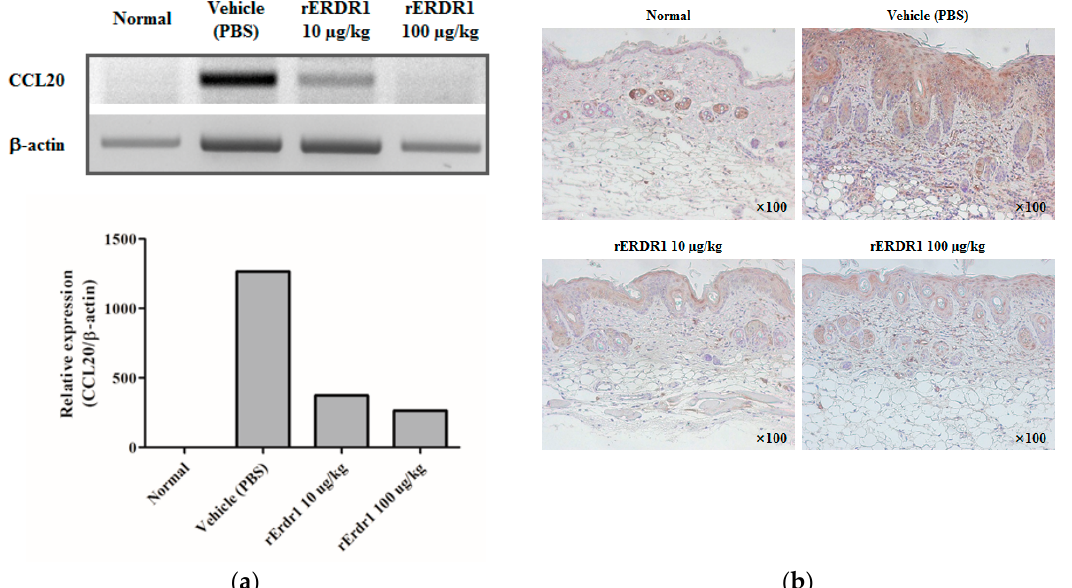
Figure 3. Recombinant ERDR1 inhibits CCL20 expression, resulting in decreased CCR6+ cells in psoriatic lesional skin. ( a ) Expression of CCL20, a chemokine for the trafficking of Th17 cells, was detected using RT-PCR. The increased CCL20 mRNA expression by imiquimod treatment was